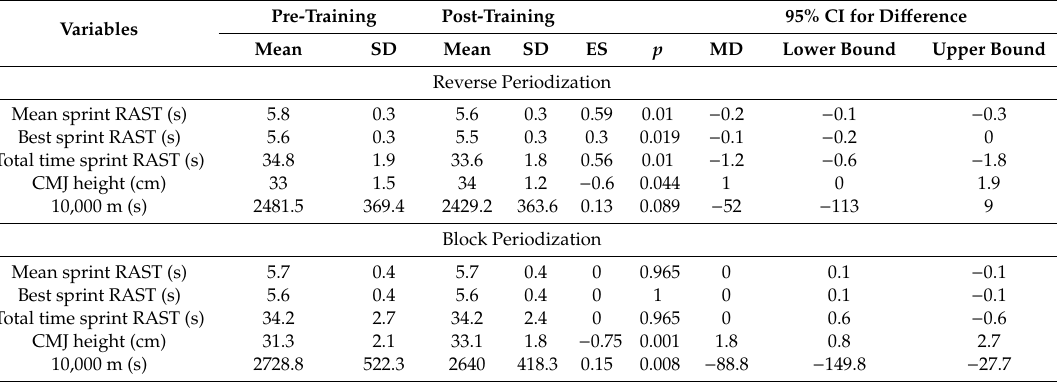
Table 4. Countermovement jump test, RAST test, and 10,000 m time trial test results in both groups.